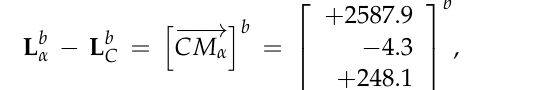
α and β respectively. The specific s o for triads